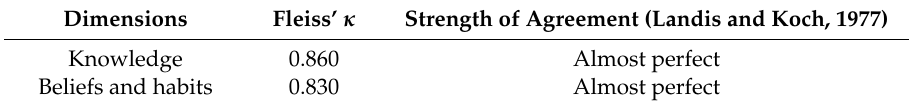
Table 4. Strength of agreement among judges for the dimensions of the original instrument.